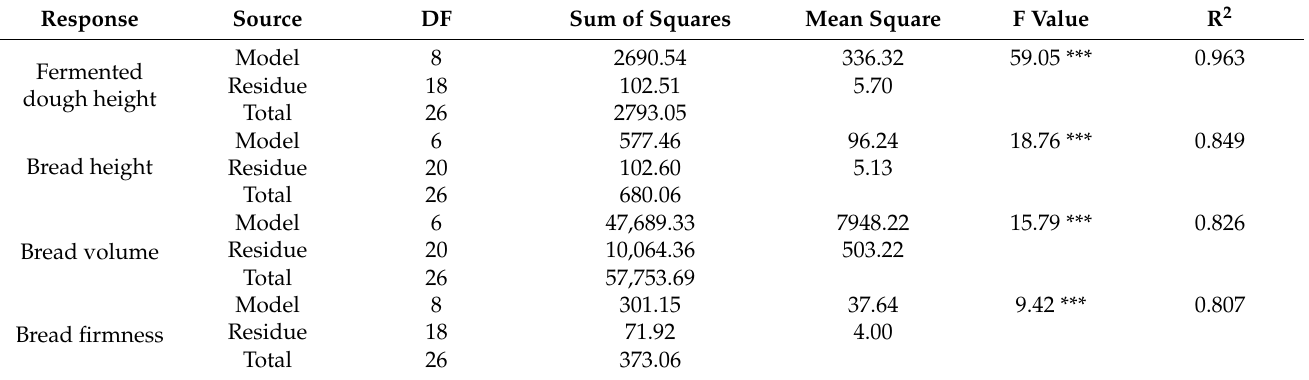
Table 5. Analysis of variance of the response surface reduced quadratic models for fermented dough height and height, volume, and firmness of bread prepared with ‘O-free’